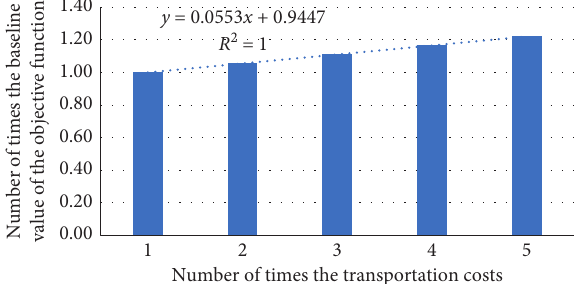
Figure 6: Sensitivity analysis performed on transportation